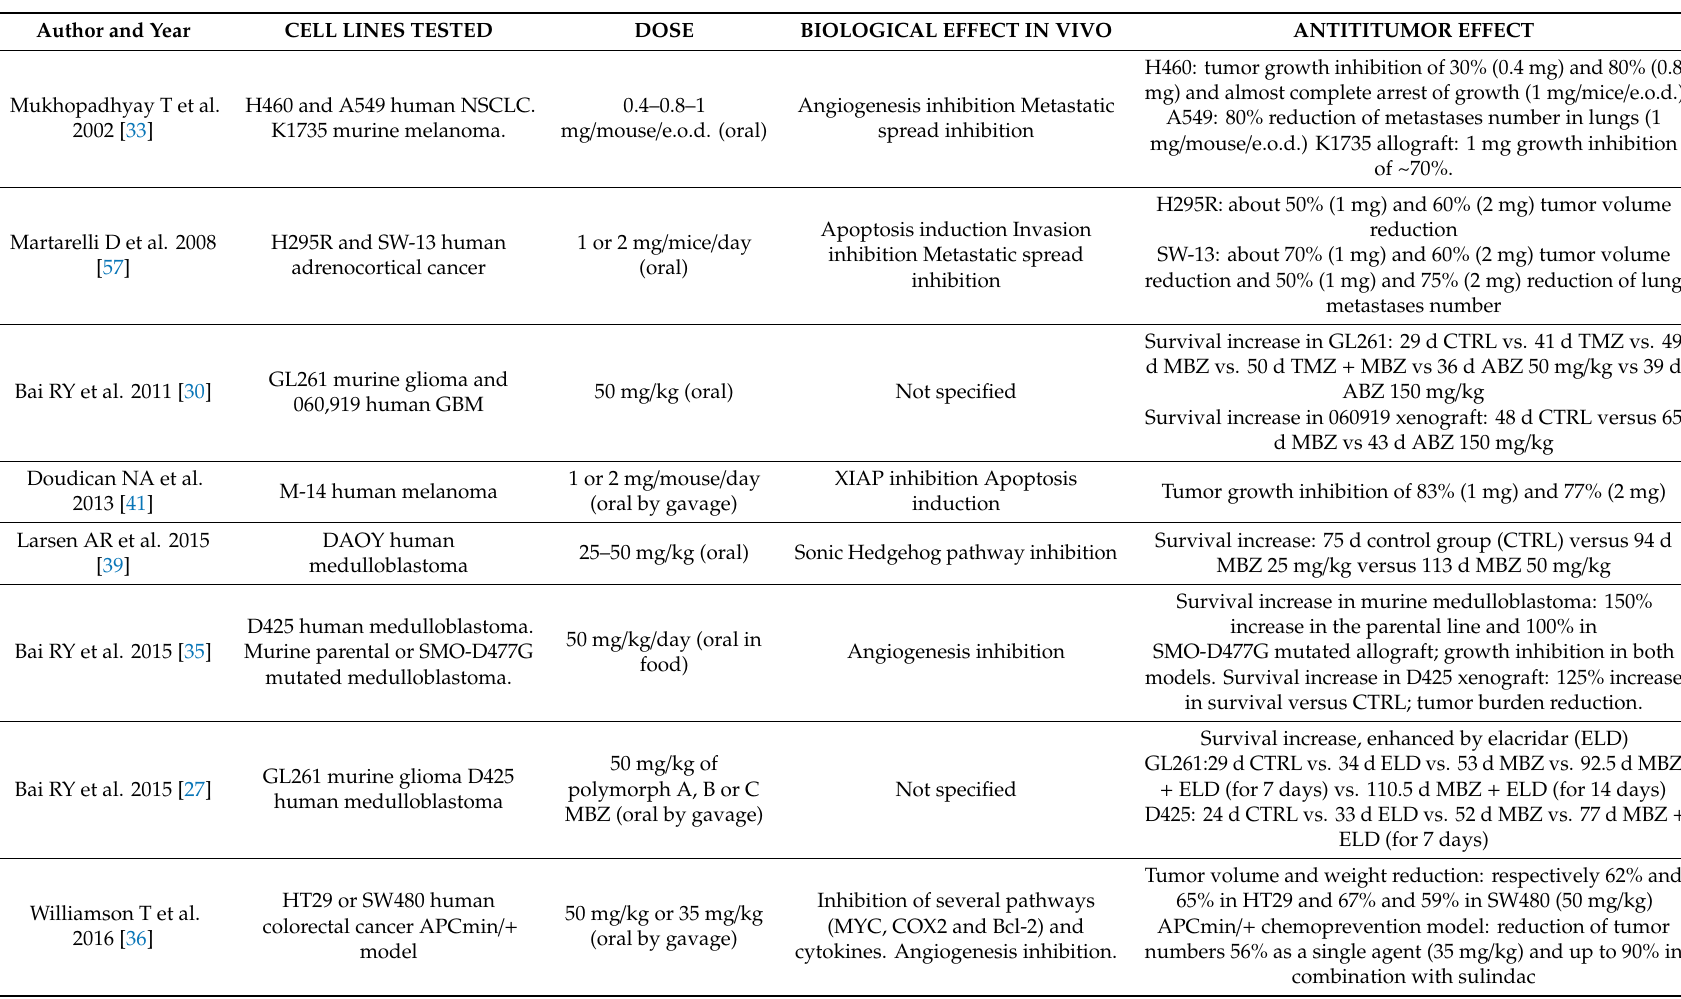
Table 4. Studies reporting MBZ anticancer activity in vivo and its mechanisms of action. Abbreviations: e.o.d = every other day; I.p. =